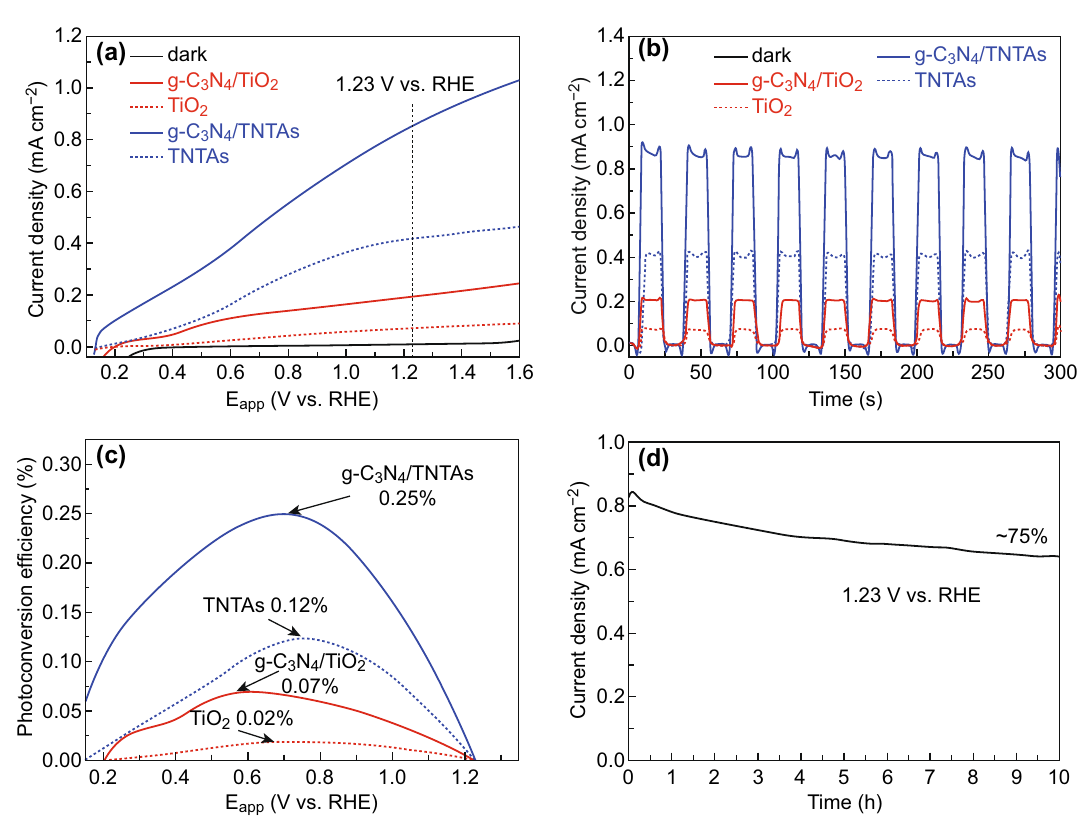
Fig. 7 a Current–potential curves of the g-C 3 N 4 /TNTA photoanode and reference samples (TNTAs, amorphous TiO 2 , and g-C 3 N 4 /TiO 2 ) under light irradiation (100 mW cm - 2 ). The dark line indicates the dark current density. b Time-dependent photocurrent density of different photoanodes under intermittent light irradiation. c Photoconversion efficiency as a function of applied potential for different photoanodes. d Chronoamperometry plot ( I–t ) of the g-C 3 N 4 /TNTAs measured in 0.1 M Na 2 SO 4 with a three-electrode system at 1.23 V RHE for 10